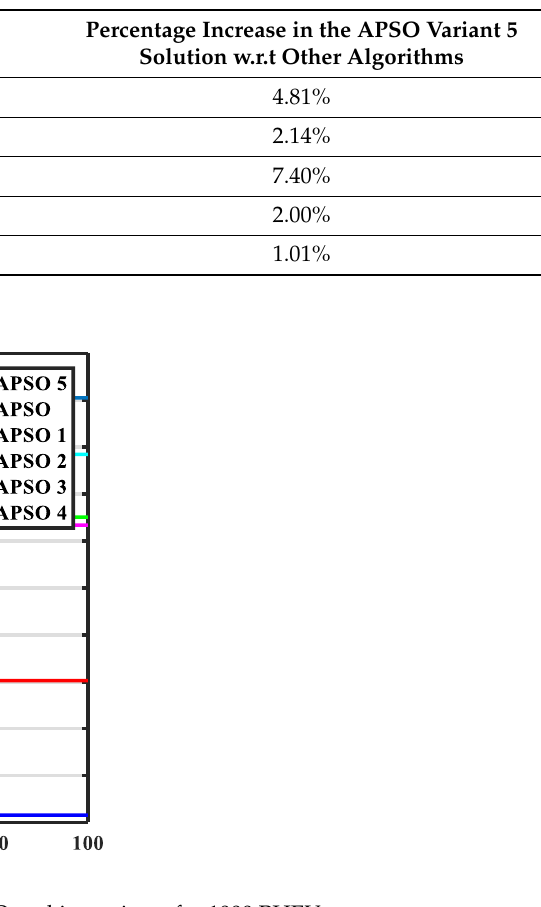
Figure 7. Results comparison between APSO and its variants for 1000 PHEVs.